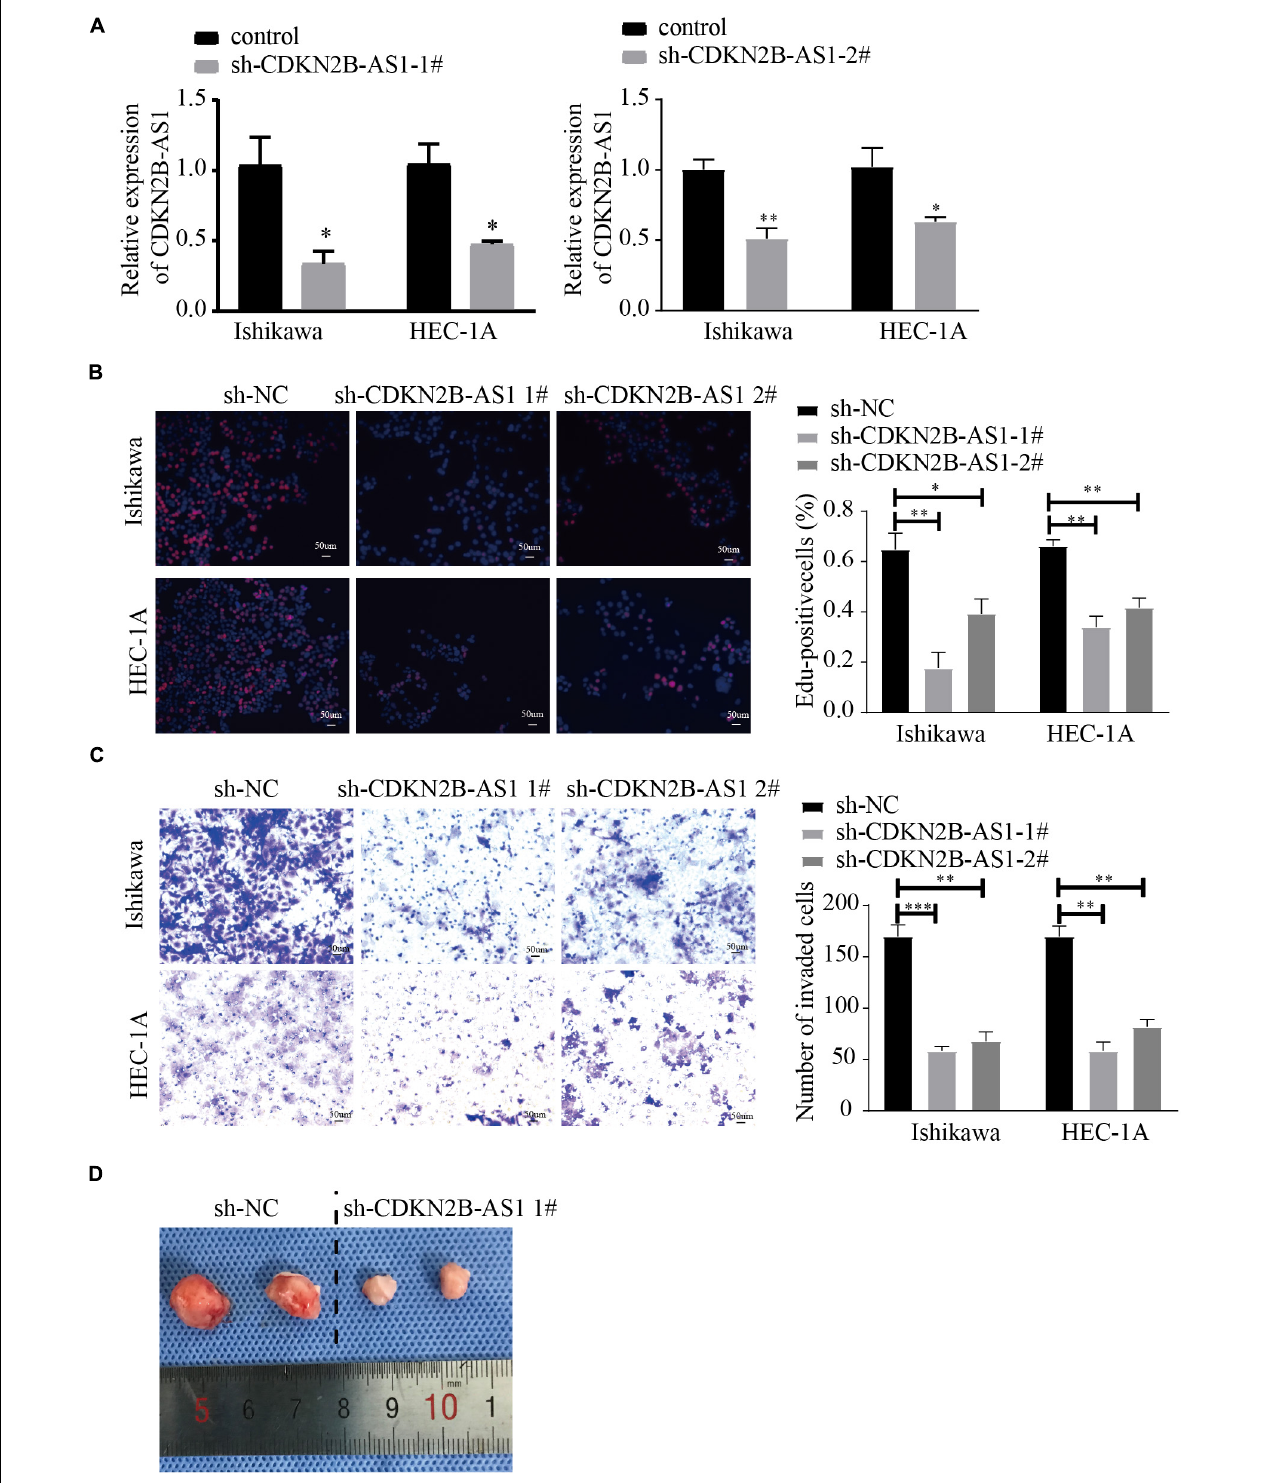
FIGURE 8 | CDKN2B-AS1 knockdown inhibits malignant biological behavior in EC cells. (A) CDKN2B-AS1 expression in Ishikawa and HEC-1A cell lines measured using RT-qPCR. (B) Effect of CDKN2B-AS1 expression on proliferation determined using EdU assays in Ishikawa and HEC-1A cells. (C) Transwell assays to determine the number of invading cells. (D) Nude mice bearing tumors. A specimen from each respective group is shown ( n = 2 per group), ∗ p < 0.05, ∗∗ p < 0.01, ∗∗∗ p < 0.001 vs. the NC group.